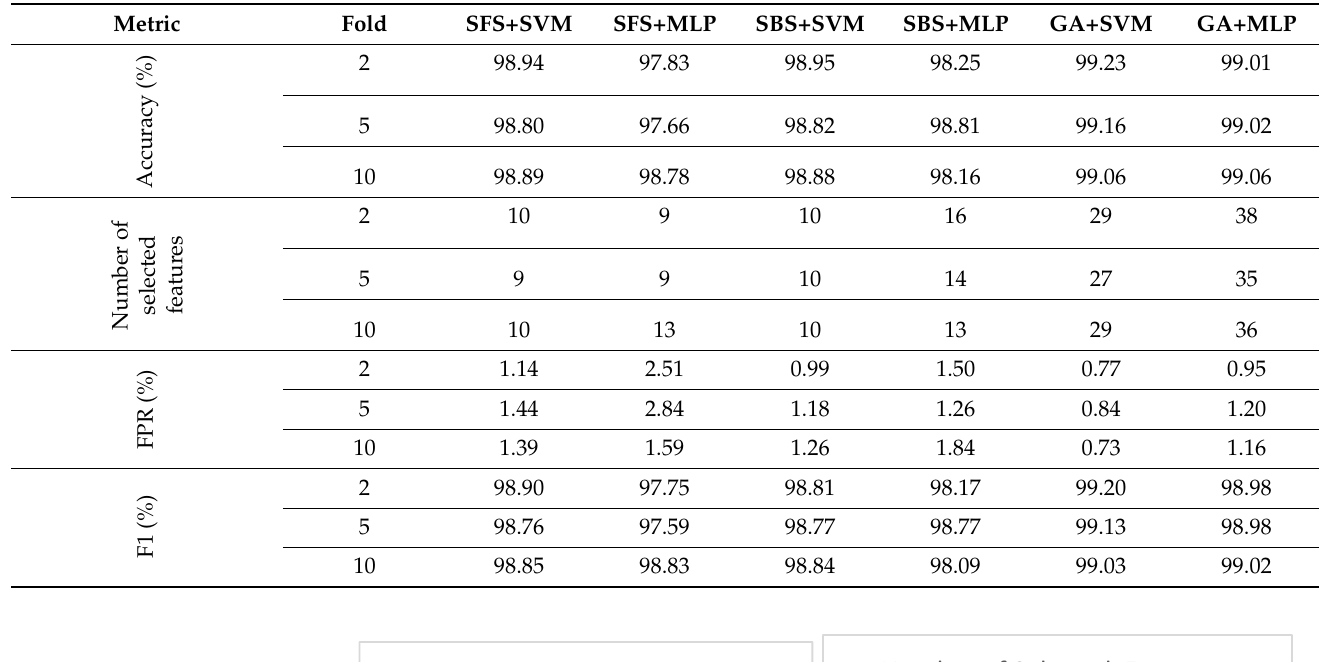
Table 6. Performance of SFS, SBS and the GA using objective function based on accuracy and number of selected features in NSL-KDD.